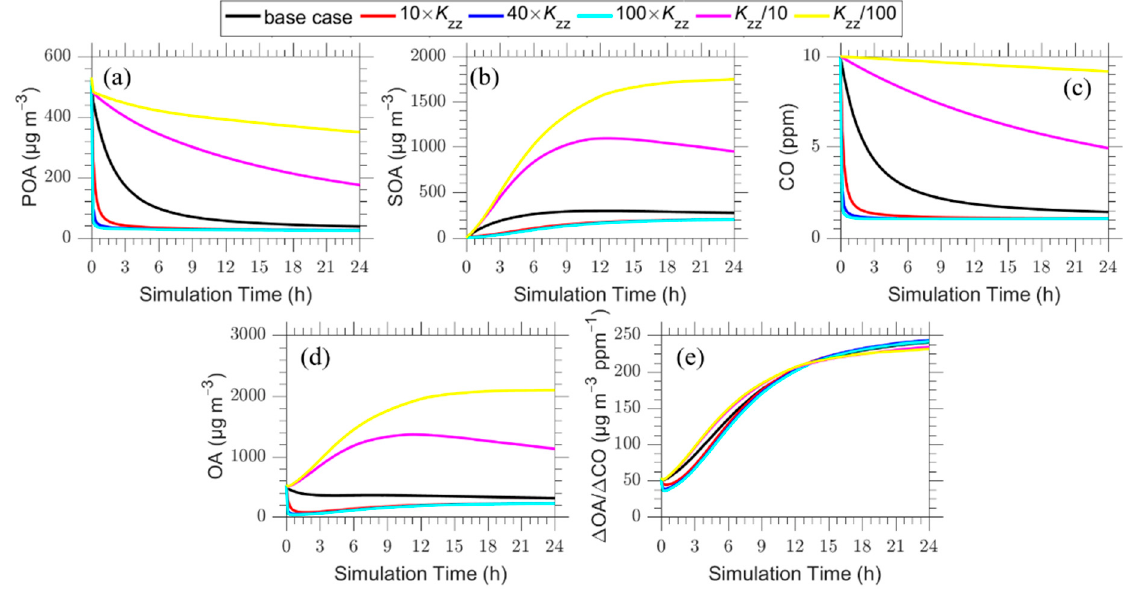
Figure 12. Time series of: ( a ) POA; ( b ) SOA; ( c ) CO; ( d ) total OA; and ( e ) ∆ OA/ ∆ CO for the plume centerline for the base case ( K zz = 5 m 2 s − 1 ) ( black line ) and the sensitivity cases with vertical dispersion K zz = 50 m 2 s − 1 ( red line ), 200 m 2 s − 1 ( blue line ), 500 m 2 s − 1 ( cyan line ), 0.5 m 2 s − 1 ( magenta line ) and 0.05 m 2 s − 1 ( yellow line ).